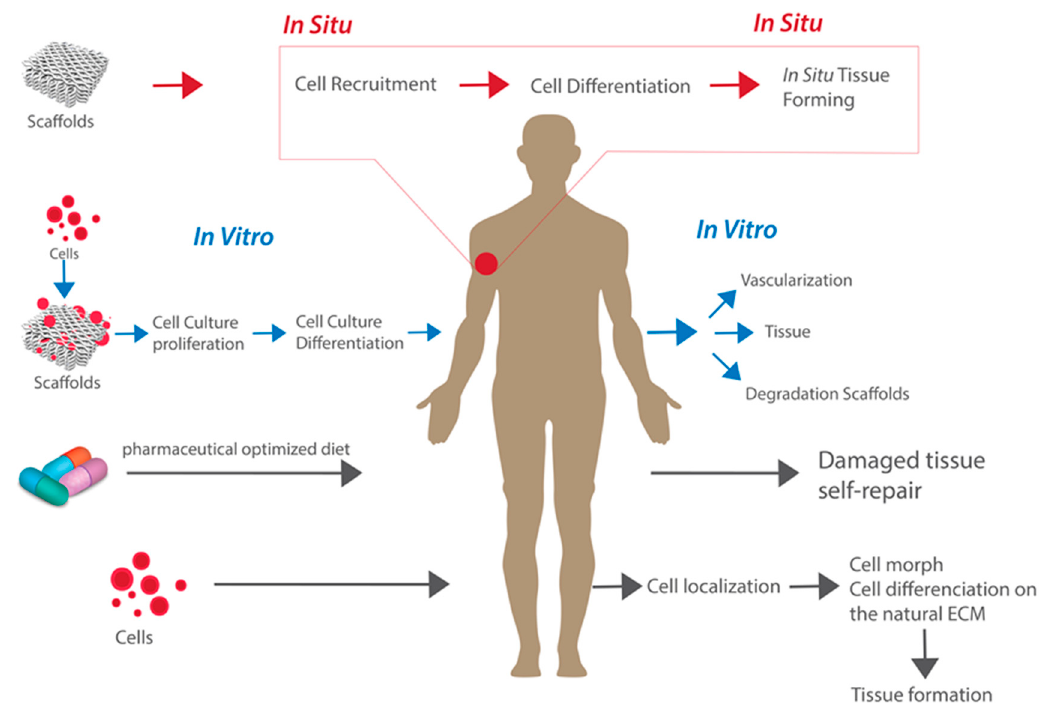
Figure 1. Pathways for tissue regeneration.